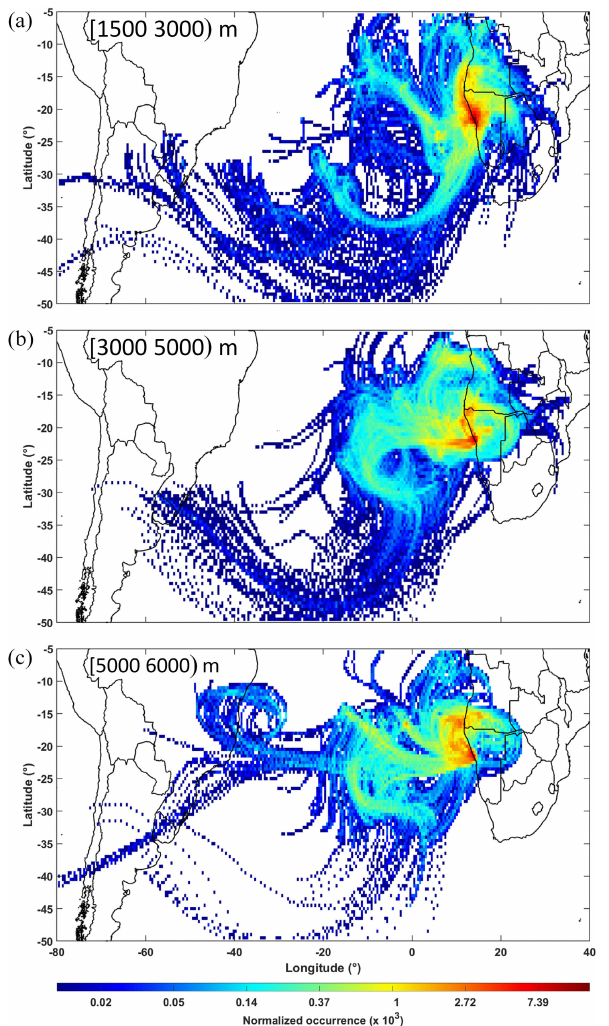
Figure 14. Normalized occurrence of the back trajectories start- ing over Henties Bay at 12:00UTC during period P 2 from the altitude ranges of [1500 3000[ (a) [3000 5000[ (b) and [5000 6000[ma.m.s.l. (c) . The calculations have been made using 6d isentropic back trajectories with the HYSPLIT model (courtesy of NOAA Air Resources Laboratory; http://www.arl.noaa.gov, last ac- cess: 23 November 2019) in ensemble mode. The normalization is performed with respect to the total number of pixels for a horizontal resolution of 0.5 ◦